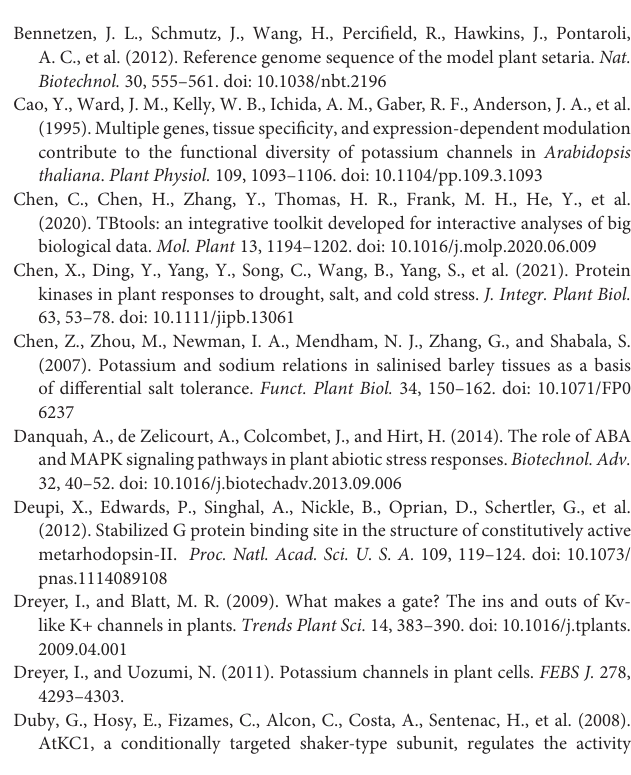
Supplementary Figure 1 | Chromosomal localization of Shaker K + channel genes from foxtail millet. The location information of 10 Shaker K + channel genes on the chromosome was obtained from the Phytozome database ( Setaria italica v2.2). Different colors on the nine chromosomes (chr1–chr9) indicate different channel groups. Supplementary Figure 2 | Cis-acting element analysis of the promoter regions of Shaker K + channel genes from foxtail millet. The number of each cis-acting element in the promoter regions (2,000 bp upstream of the translation start site) of Shaker K + channel genes was shown. Based on the functional annotations, the cis-acting elements were classified into three major classes: plant growth and development, phytohormone responsiveness, and abiotic/biotic stresses related cis-acting elements. Supplementary Figure 3 | Prediction of post-translational modification sites and ABA binding sites in the amino acid sequences of Shaker K + channel proteins from foxtail millet. (A) N -glycosylation site; (B) phosphorylation site; (C) ABA binding sites in GORK and SKOR. Supplementary Figure 4 | The phenotype of “Jingu21” seedlings after 24 h treatment of different abiotic stresses (A) or phytohormones (B) . Supplementary Figure 5 | The transcript levels of six Shaker K + channels did not change without abiotic stresses. (A) Seedlings of “Jingu 21” grow in soil (control for cold or hot treatments). (B) Seedlings of “Jingu 21” grow in liquid medium (control for salt, PEG, and phytohormone treatments). The Student’s t -test was used to analyze statistical significance. Compared to that at 0 h, the transcript levels of Shaker K + channels at 12 and 24 h showed no difference ( P > 0.05). Supplementary Figure 6 | The transcripts of SiKC1a and SiKC1b could not be detected by RT-PCR in different cultivates. The transcripts of SiKC1a (Seita.5G298000) and SiKC1b (Seita.1G210600) were tested by RT-PCR in 14 days old seedlings of “Jingu21,” “Longgu16,” and “Jigu39.” R means root, and L means leaf. SiAKT1 was used as positive control. SiAct2 was used as the internal reference. In all three cultivates, there are similar strong bands for SiAKT1, supporting the RNA-seq analysis in Figure 3